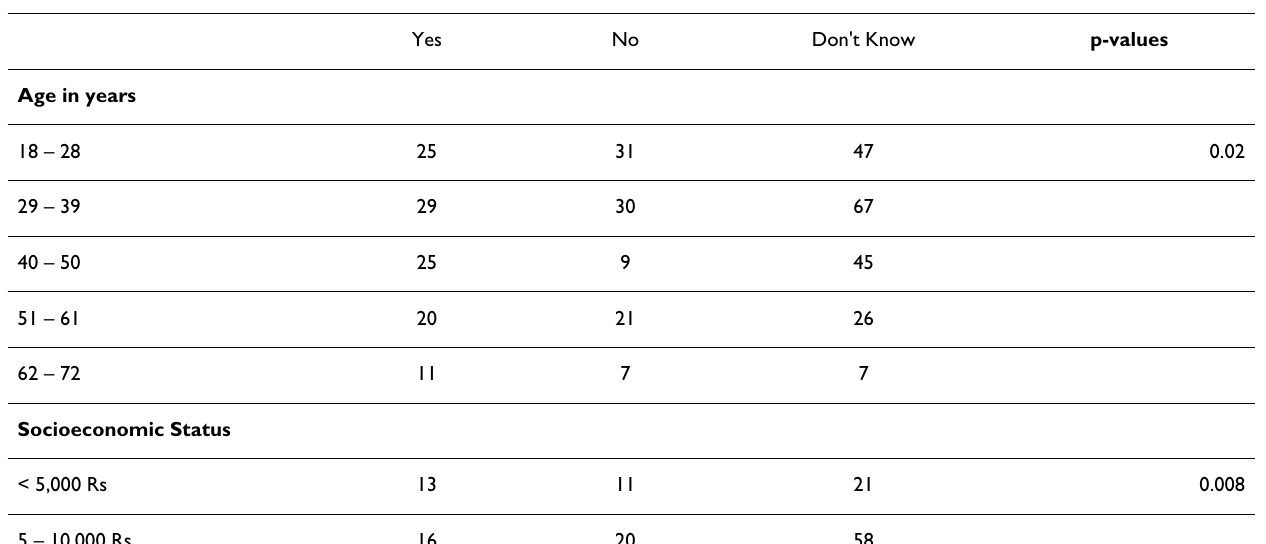
Table 6: Association of gemstone use based on religious beliefs